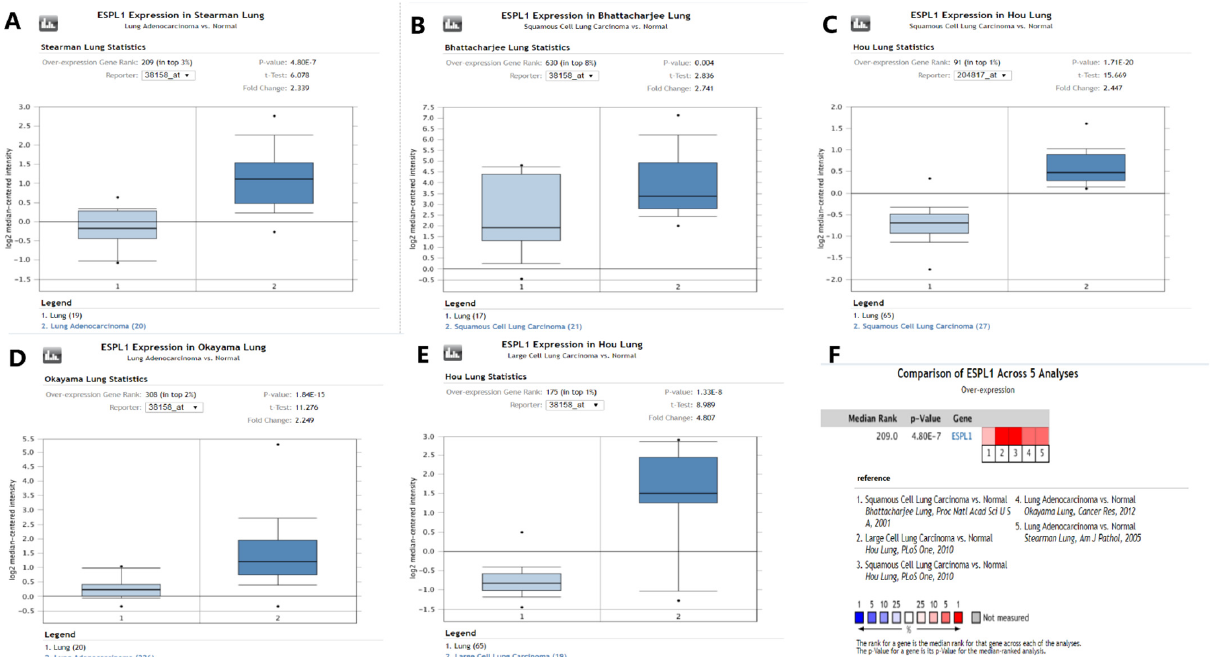
Figure 10. Expression profile for ESPL1 from the Oncomine database. ( A – E ) Expression of Timeless gene in the five lung cancer datasets. ( F ) Comparison of ESPL1 across the five datasets. ESPL1, extra spindle pole bodies like 1.